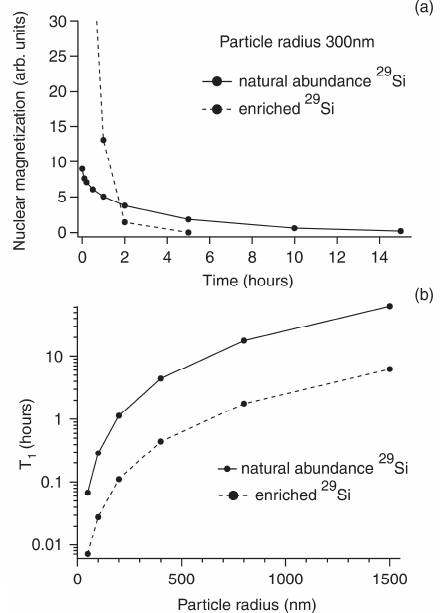
Figure 14. ( a ) Simulations of the 29 Si magnetization decay due to spin diffusion and instantaneous relaxation at the surface for particles with 300 nm radius. ( b ) Simulated T 1 relaxation time as a function of the particle size. Solid line is for the naturally abundant 29 Si and dashed line is for the 29 Si enriched sample. (Reprinted figure with permission from Reference [51] © (2008) by the American Physical Society).